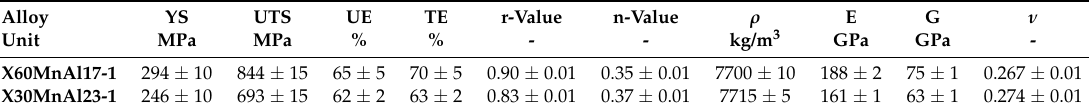
Figure 4. Macroscopic material response: ( a ) True stress-strain curves ( b ) Strain-hardening behavior. Table 3. Mechanical properties of Al-added TWIP steels: Yield/ultimate tensile strength (YS/UTS), uniform/total elongation (UE/TE), Lankford coefficient (r-value), strain hardening exponent (n-value), density ( ρ ), Young’s modulus (E), shear modulus (G) and Poisson’s ratio ( ν ). All data are average values determined from at least three parallel